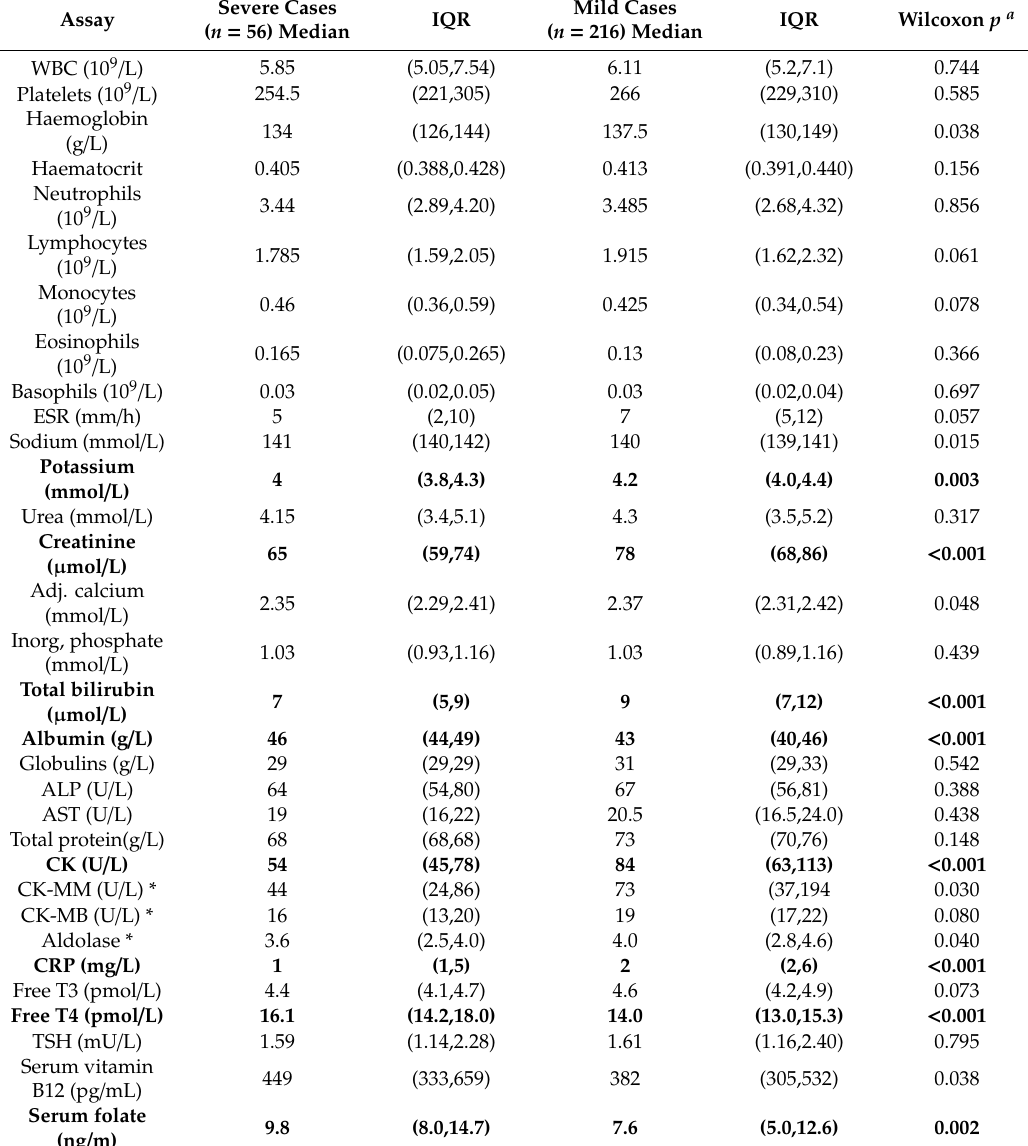
Table 3. Comparison of baseline laboratory haematological and biochemical test results from severe and mild / moderate ME / CFS